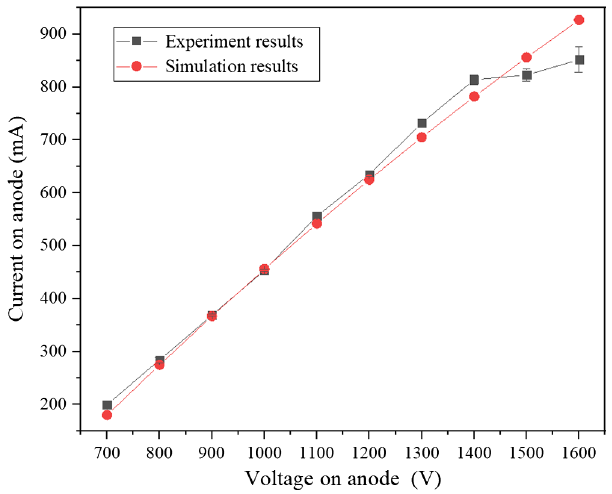
FIG. 8. The experimental and simulation results of the dis- charge current with respect to the anode voltage (discharge gap fixed at 6